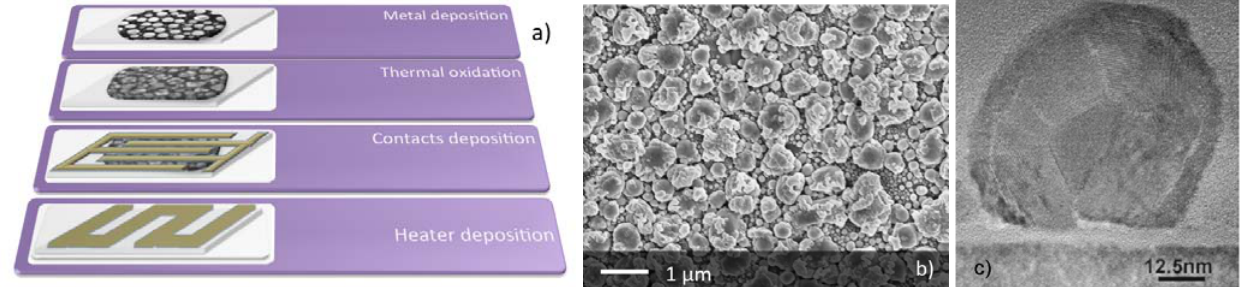
Figure 3. Different steps for the preparation of chemical sensors based on RGTO thin-films ( a ); SEM image of the morphology of a SnO technique ( b ). TEM image of single particle of the RGTO layer ( c ), (reprinted from [13] with permission of Elsevier, copyright 2000).